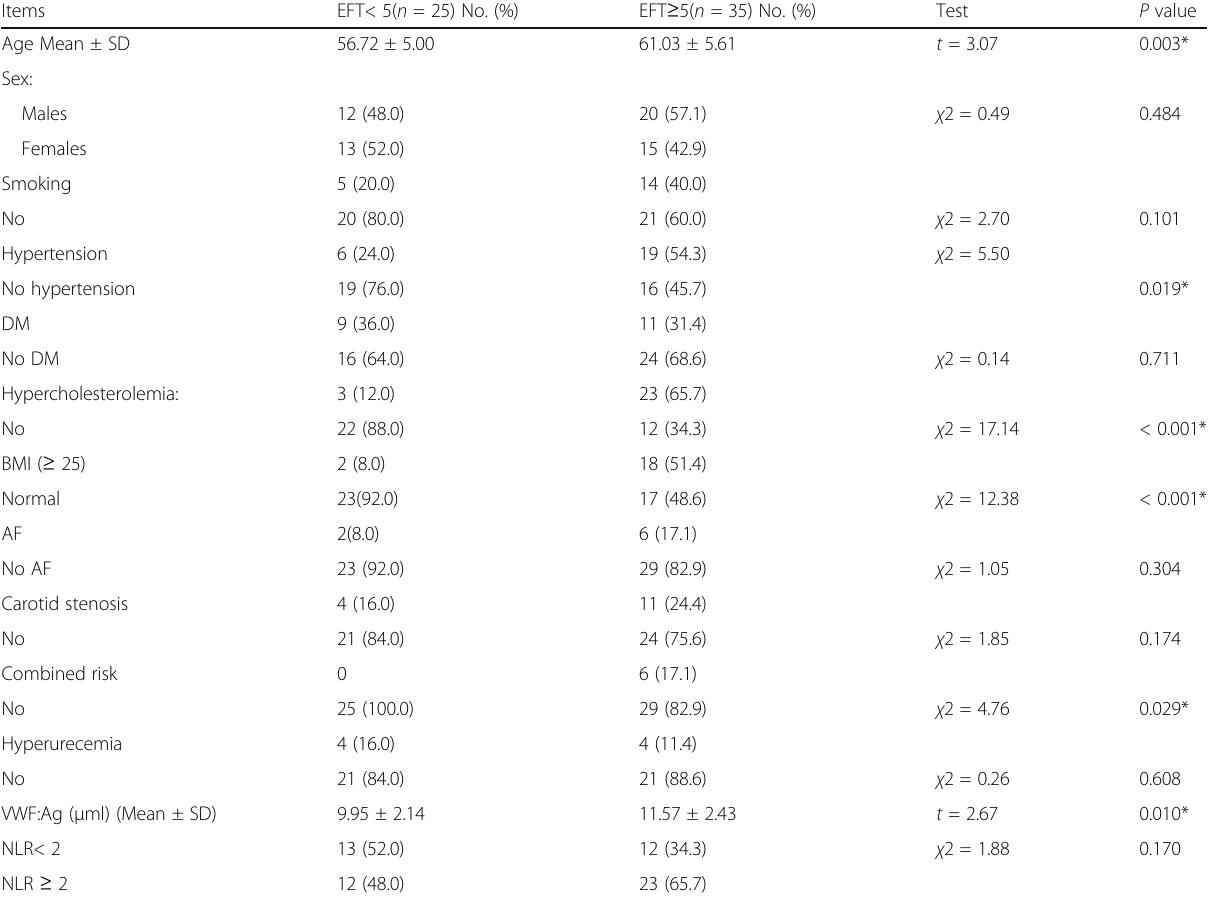
Table 2 Comparison between patients with EFT< 5 mm and those ≥ 5 regarding risk factors, NLR and